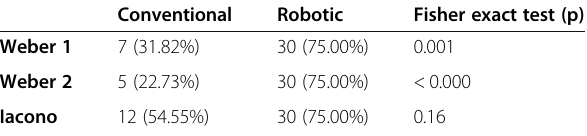
Table 4 The proportion of patients that achieve the position of the femoral component two millimeters or below to the femoral joint line by type of UKA is shown, according to the three